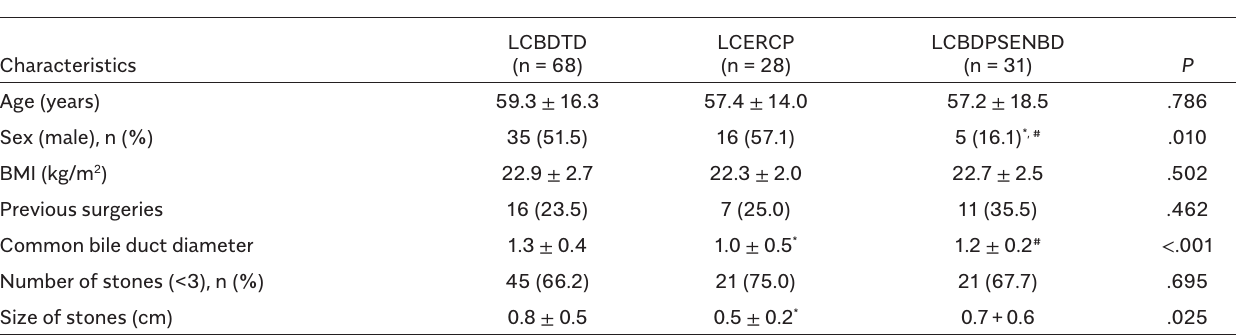
Table 1. Patient Characteristics and Surgical Results